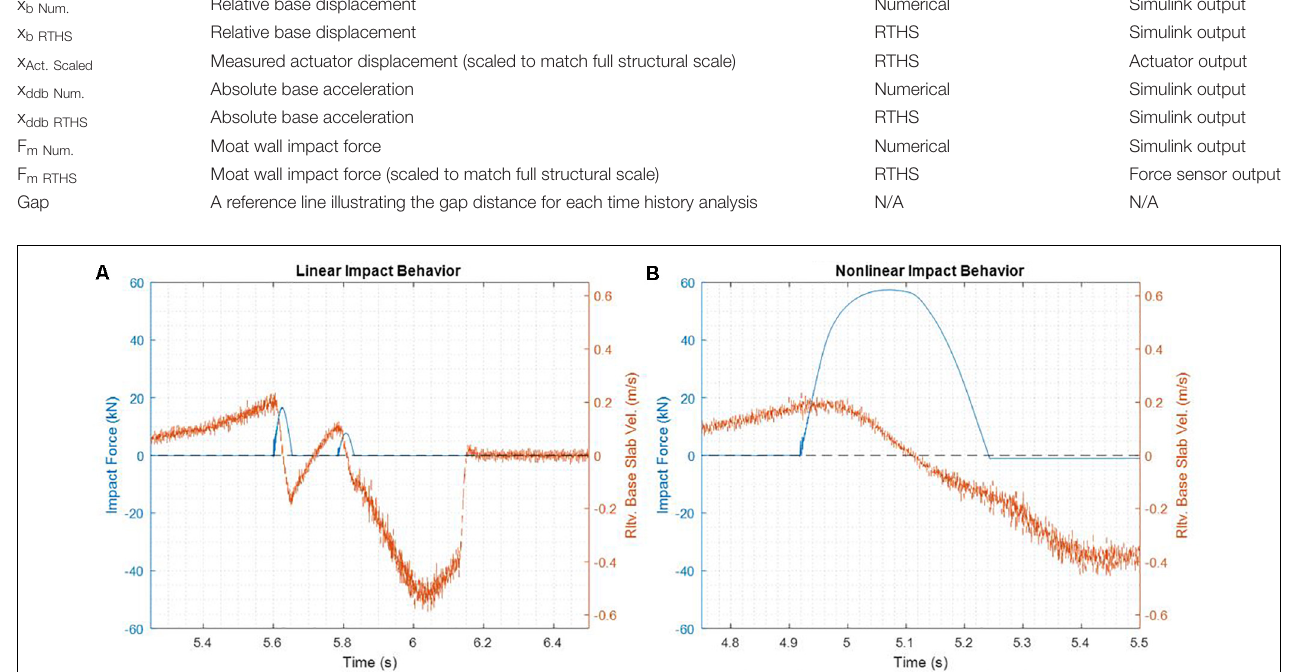
FIGURE 11 | Time history of impact force and measured actuator velocity for the (A) linear and (B) nonlinear Northridge Impact Scenarios.